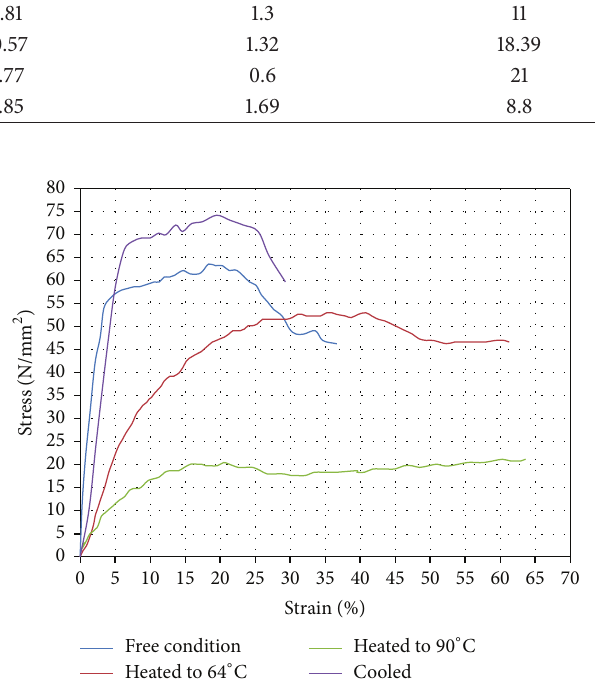
Figure 9: Stress-strain diagrams at different working